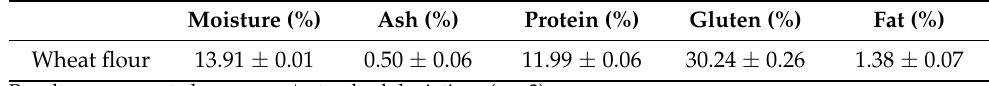
Table 3. Proximate composition of wheat